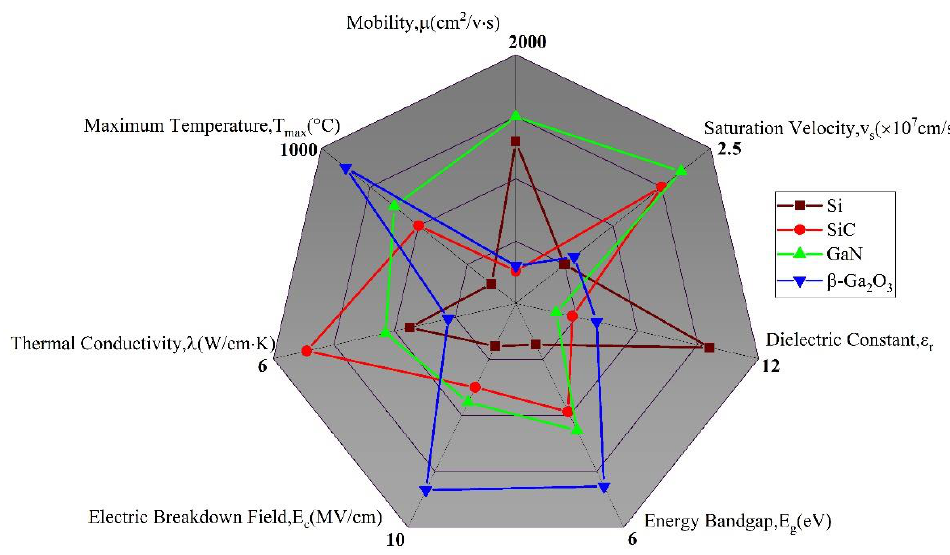
Figure 9. Comparison of wide bandgap materials with Si.